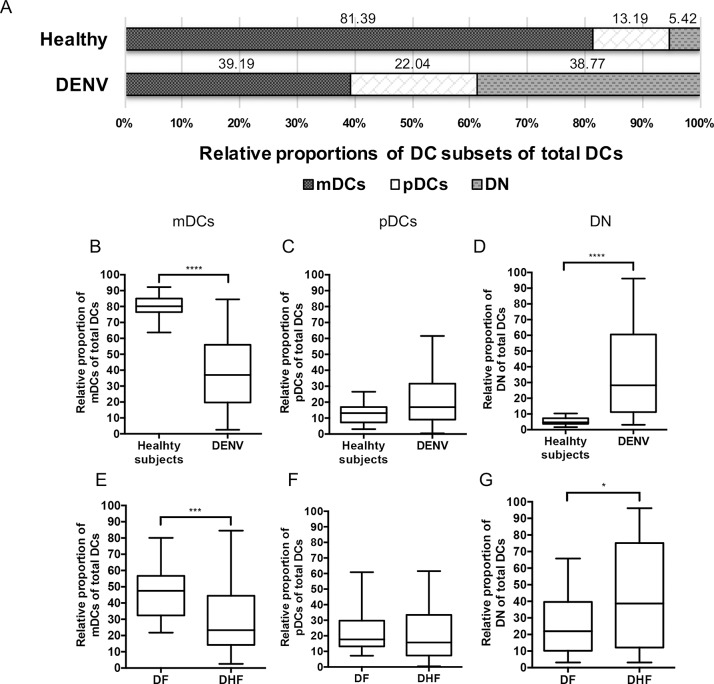
Comparison of the relative proportion of mDCs, pDCs and DN subset in blood samples from DENV infected patients and healthy subjects.The mean of relative proportion (%) of mDCs, pDCs, and DN were analyzed in blood samples from 68 DENV-infected samples and 14 healthy returned subjects (A). The relative proportion of mDCs (B) pDCs (C) and DN subsets (D) were compared between healthy and DENV-infected patients. The relative proportion of mDCs (E), pDCs (F) and DN subsets (G) were compared between DF and DHF patients. The box plot shows the median value (horizontal line in the box). The box and whisker represent 25th to 75th, and 10th to 90th interquartile range, respectively. P values were determined by the Mann-Whitney U test for comparison of two groups. (* p < 0.05, *** p < 0.001 and **** p < 0.0001).